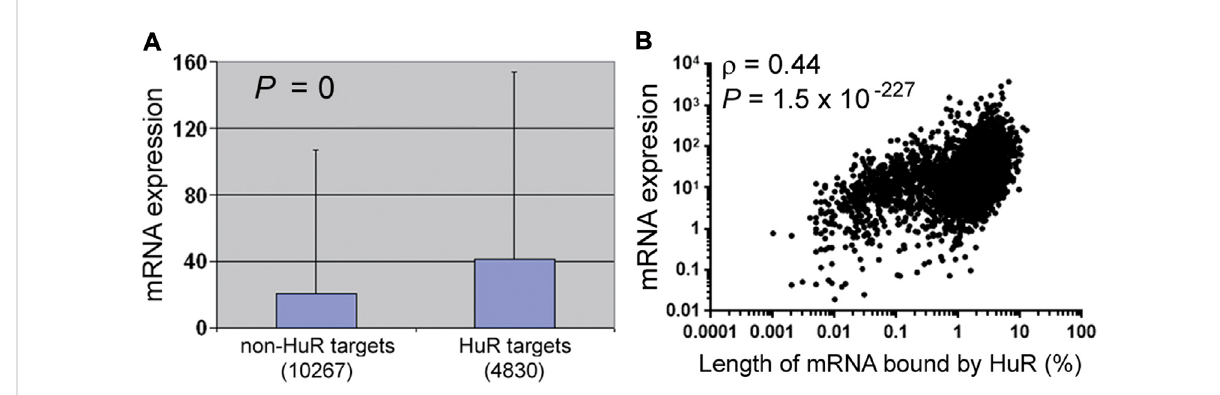
FIGURE 1 Effects of HuR binding on RNA expression in 293T cells. (A) Comparisons of the RNA expression levels of non-HuR targets and HuR targets [GSE29943andSupplementaryTableS2from(Lebedevaetal.,2011)].RNAswithfragmentsperkilobaseoftranscriptpermillionmappedreadsabove 0 (the y -axis) were counted, and the numbers of RNAs in each category are listed in parentheses. Mann – Whitney U test (SPSS, IBM, Armonk, New York) was performed to compare RNA expression, and the graph depicts the averages, standard deviations, and the p value. Corresponding to the data of Supplementary Table S1. (B) Spearman correlation analysis between HuR binding [the x -axis, Supplementary Table S2 from (Lebedeva et al., 2011)] and RNA expression (the y -axis, GSE29943). Dots represent individual HuR targets, and the correlation coef fi cient ( ρ ) and p value shown in the graph. Corresponding to the data of Supplementary Table